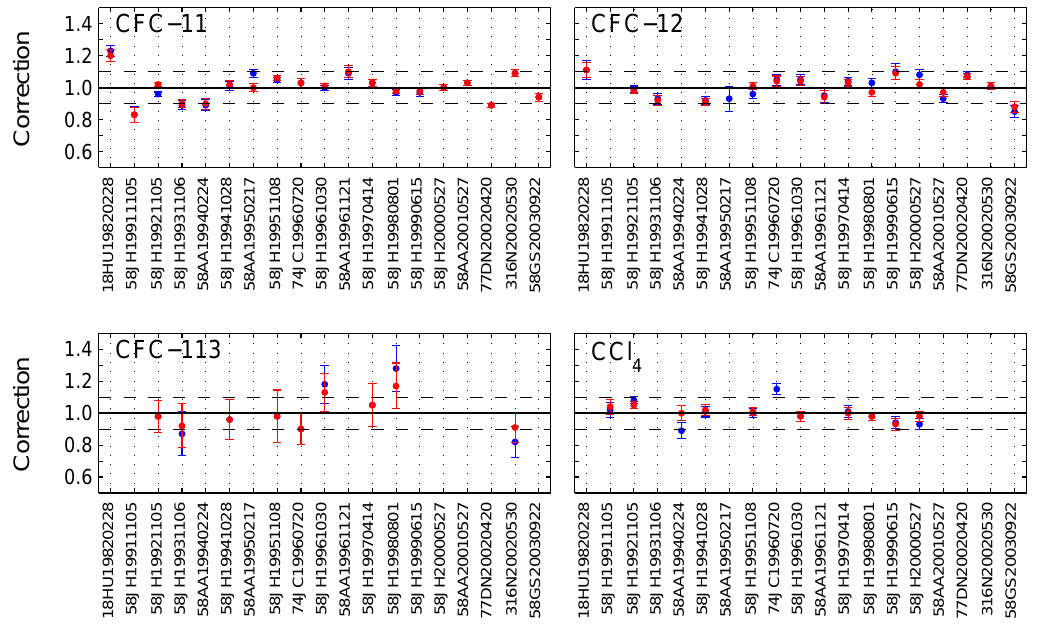
Figure 10. Suggested correction factors (and their standard deviations) of the CFCs from the cnaX inversions of the crossover analyses of the Nordic Seas data. The blue and red dots show the results before and after the adjustments were applied, respectively. 58JH19940723 and 34AR19970805 were not included in the final inversions for any of the CFCs. The cruises are sorted chronologically in order to see any trends in the